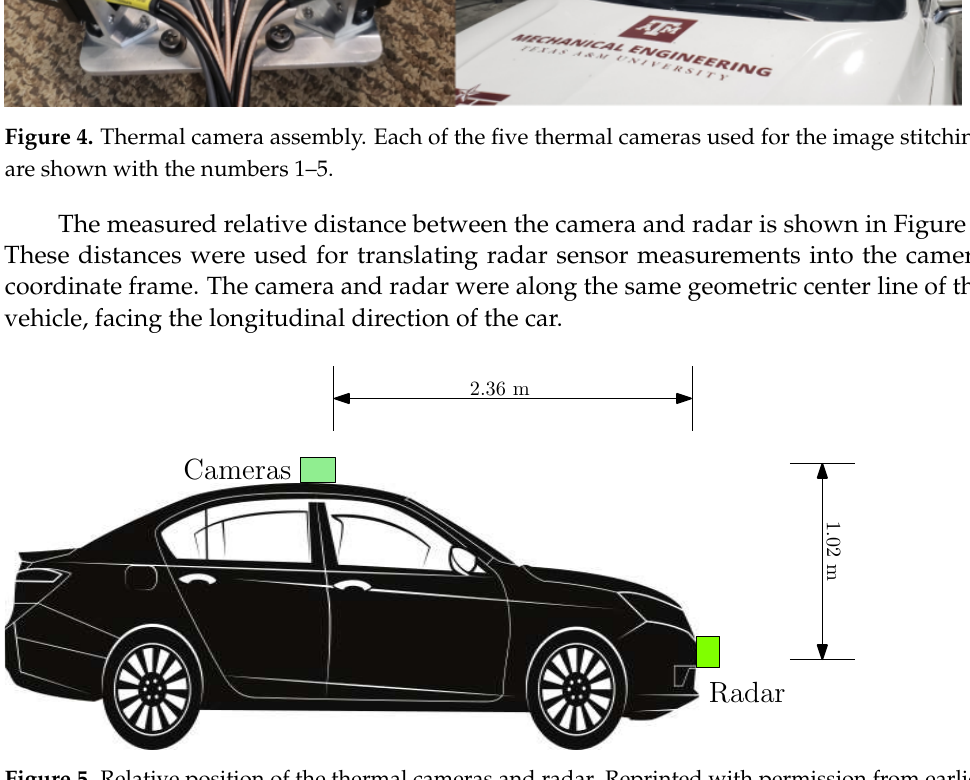
Figure 5. Relative position of the thermal cameras and radar. Reprinted with permission from earlier conference paper Ref. [11]. ©2021, SAE